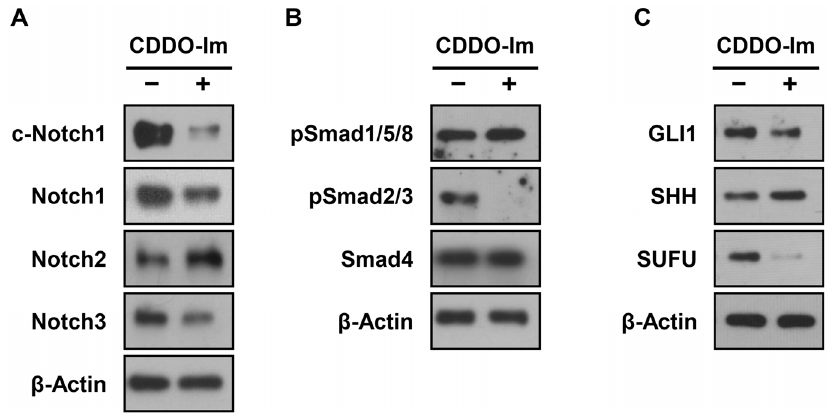
Figure 6. Regulation of the stem cell signaling pathways, Notch, TGF- b /Smad and Hedgehog, by CDDO-Im in SUM159 tumorspheres. SUM159 tumorspheres were incubated with vehicle control or CDDO-Im (100 nM) for 7 days and harvested to investigate stem cell signaling. The protein levels of given molecules for ( A ) Notch, ( B ) TGF- b /Smad and ( C ) Hedgehog signaling pathways in SUM159 cells were determined by Western blot analysis. b -Actin was used as a loading